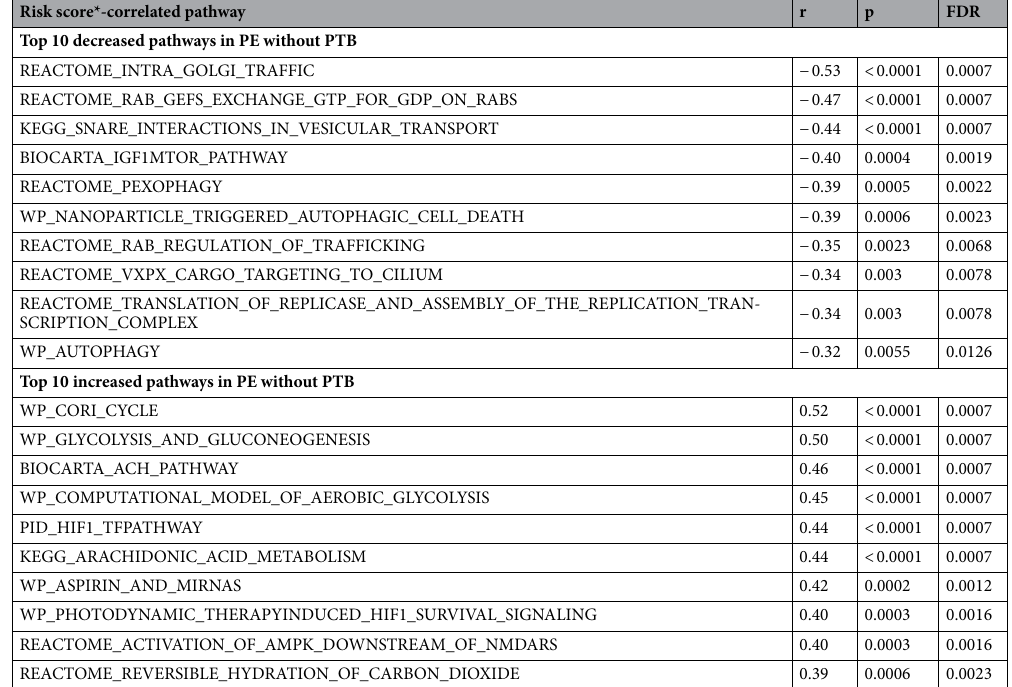
Table 5. Top 10 pathways correlated with CRY1, NR1D2 and PER3 -based risk score in placenta (PE without PTB vs. non-PE without PTB) in GSE75010-157 dataset. Cut-off: p < 0.05 and FDR < 0.10. *Risk score = (10- CLOCK ) + (11- NR1D2 ) + (9- PER3 ).